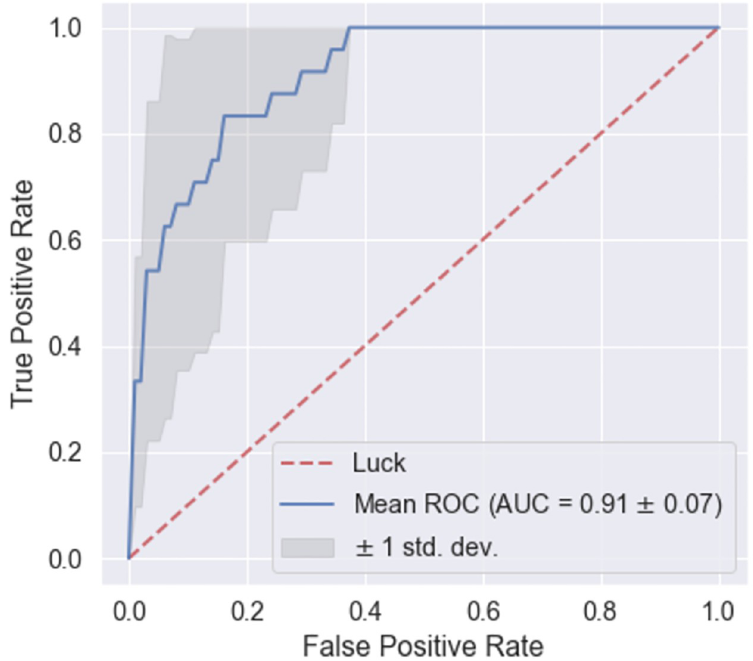
Fig 4. Mean and standard deviation of the ROC curves for different months. In this case, the task aimed to classify municipalities affected by the disease in 2018. Therefore, monthly ROC curves were constructed by considering varying cut-offs in the risk rankings proposed, i.e., changing the number of municipalities prioritized by the proposed ranking.